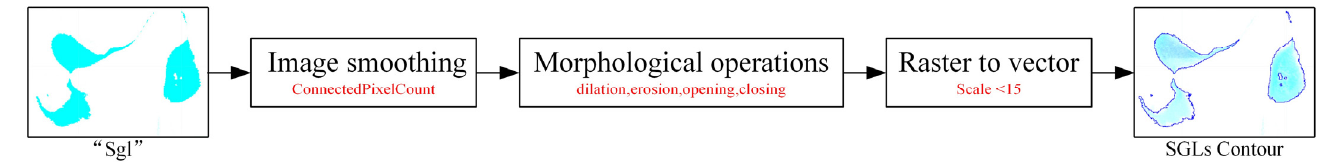
Figure 3. Flowchart of to extracted SGL contouring.